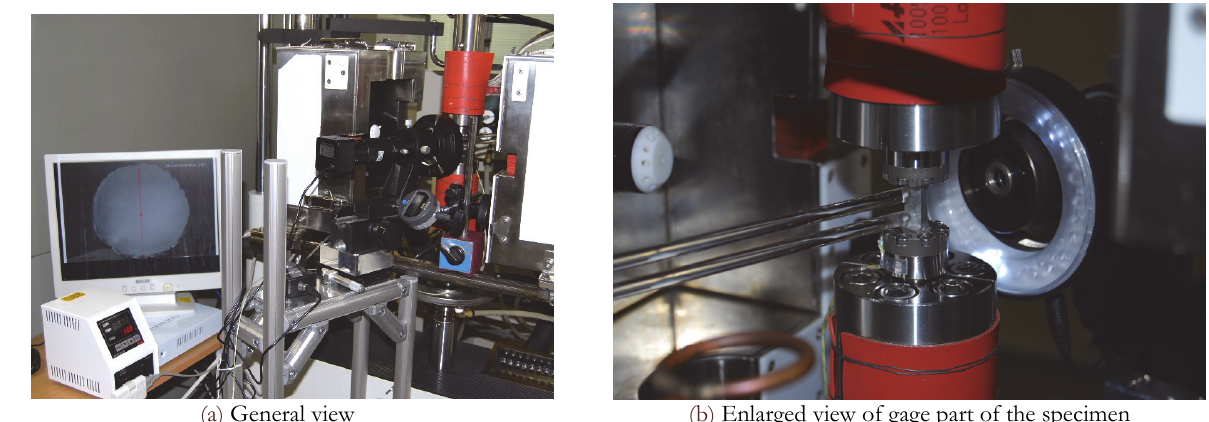
Figure 2: Cyclic push-pull loading apparatus with crack observation system.